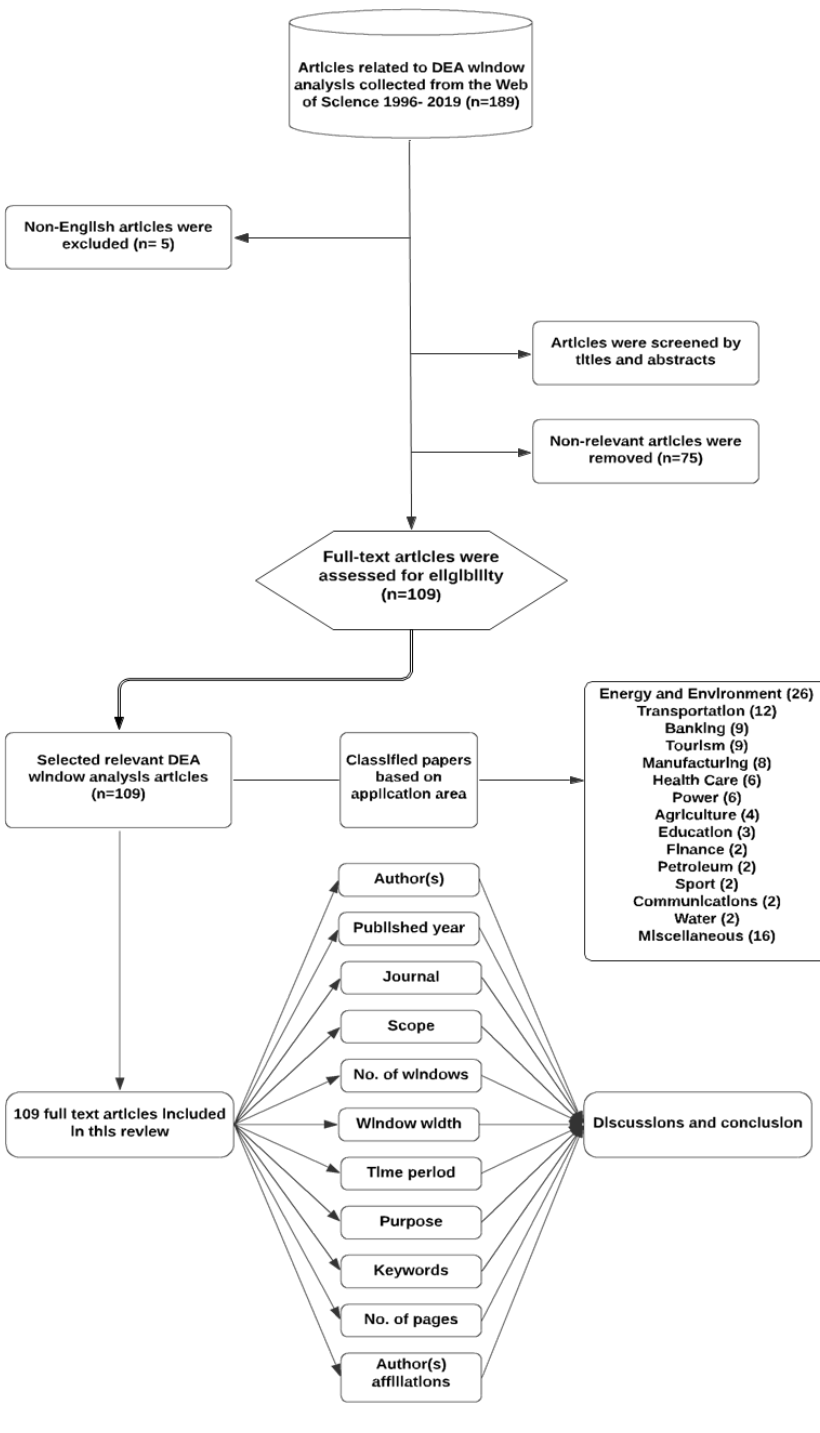
Figure 1. Analysis of articles related to Data Envelopment Analysis (DEA) window analysis.